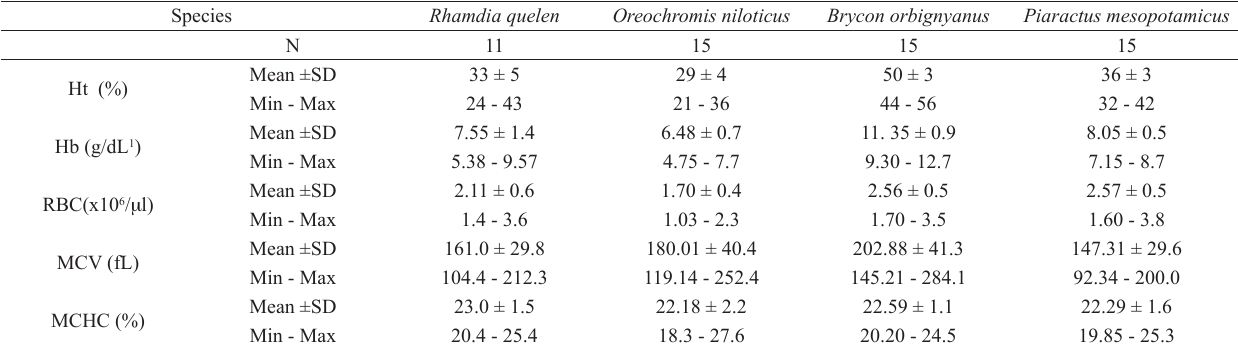
Table 1. Sample number (N), mean ± standard deviation (SD), and minimum and maximum of hematocrit (Ht; %), hemoglobin (Hb; g/dL 1 ), red blood cell (RBC; x10 6 / m l), Mean Corpuscular Volume (MCV; fL) and Mean Corpuscular Hemoglobin Concentration (MCHC; %) of Rhamdia quelen , Oreochromis niloticus , Brycon orbignyanus and Piaractus mesopotamicus maintained under controlled conditions for a period of 30 days. Rhamdia quelen